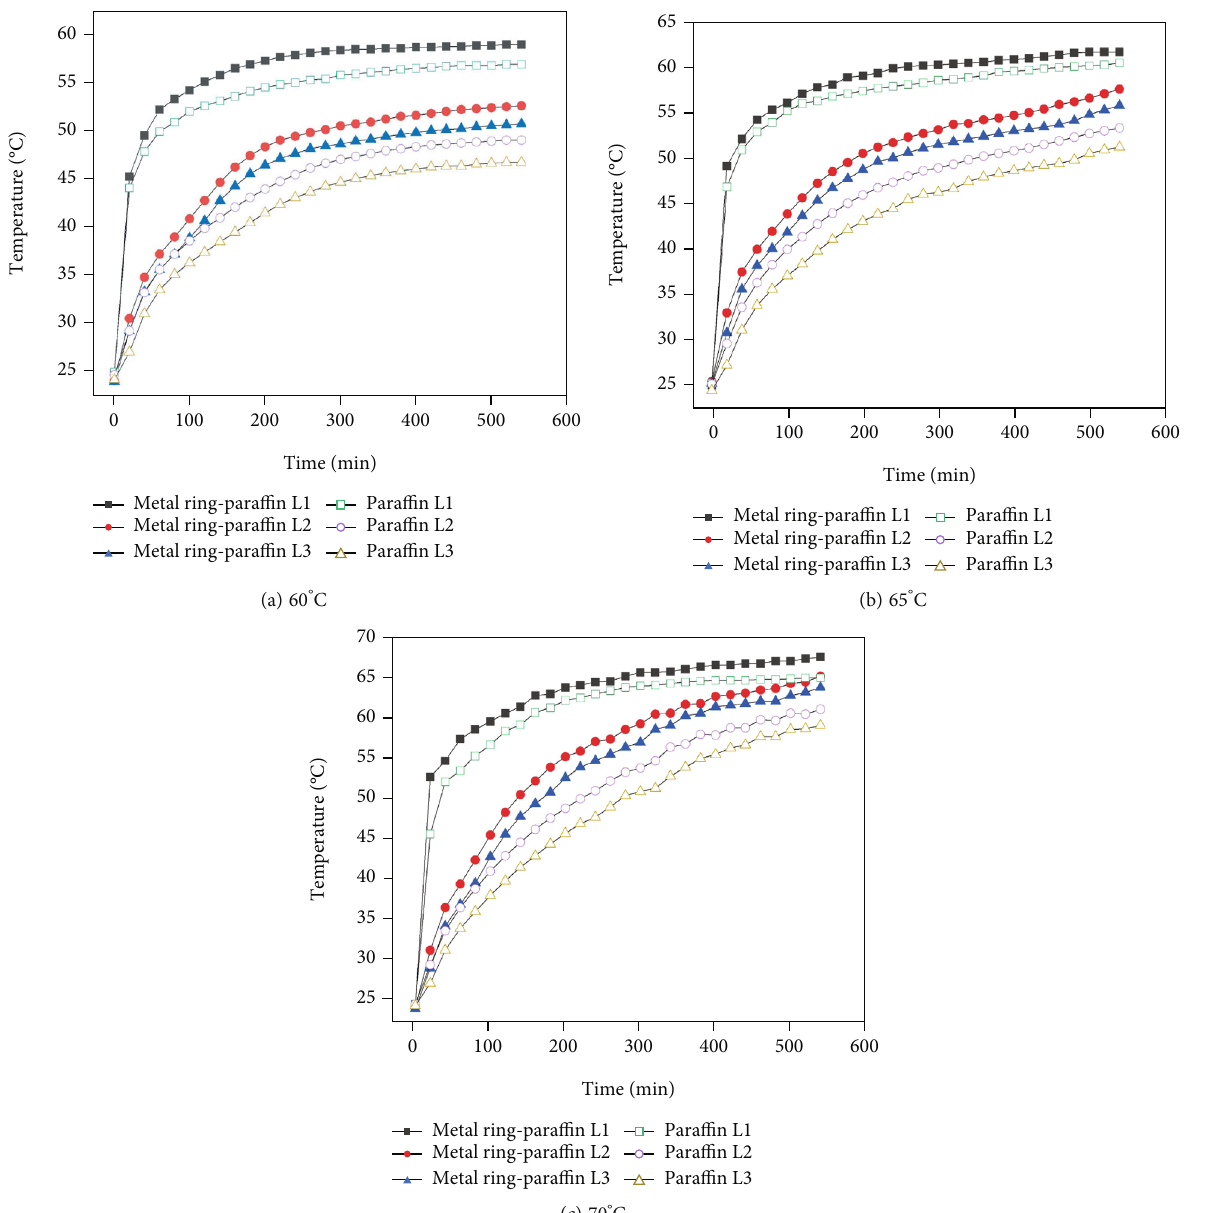
Figure 8: Temperature modifying the heat storage device dependent on the temperature of the heat source as well as fi lling